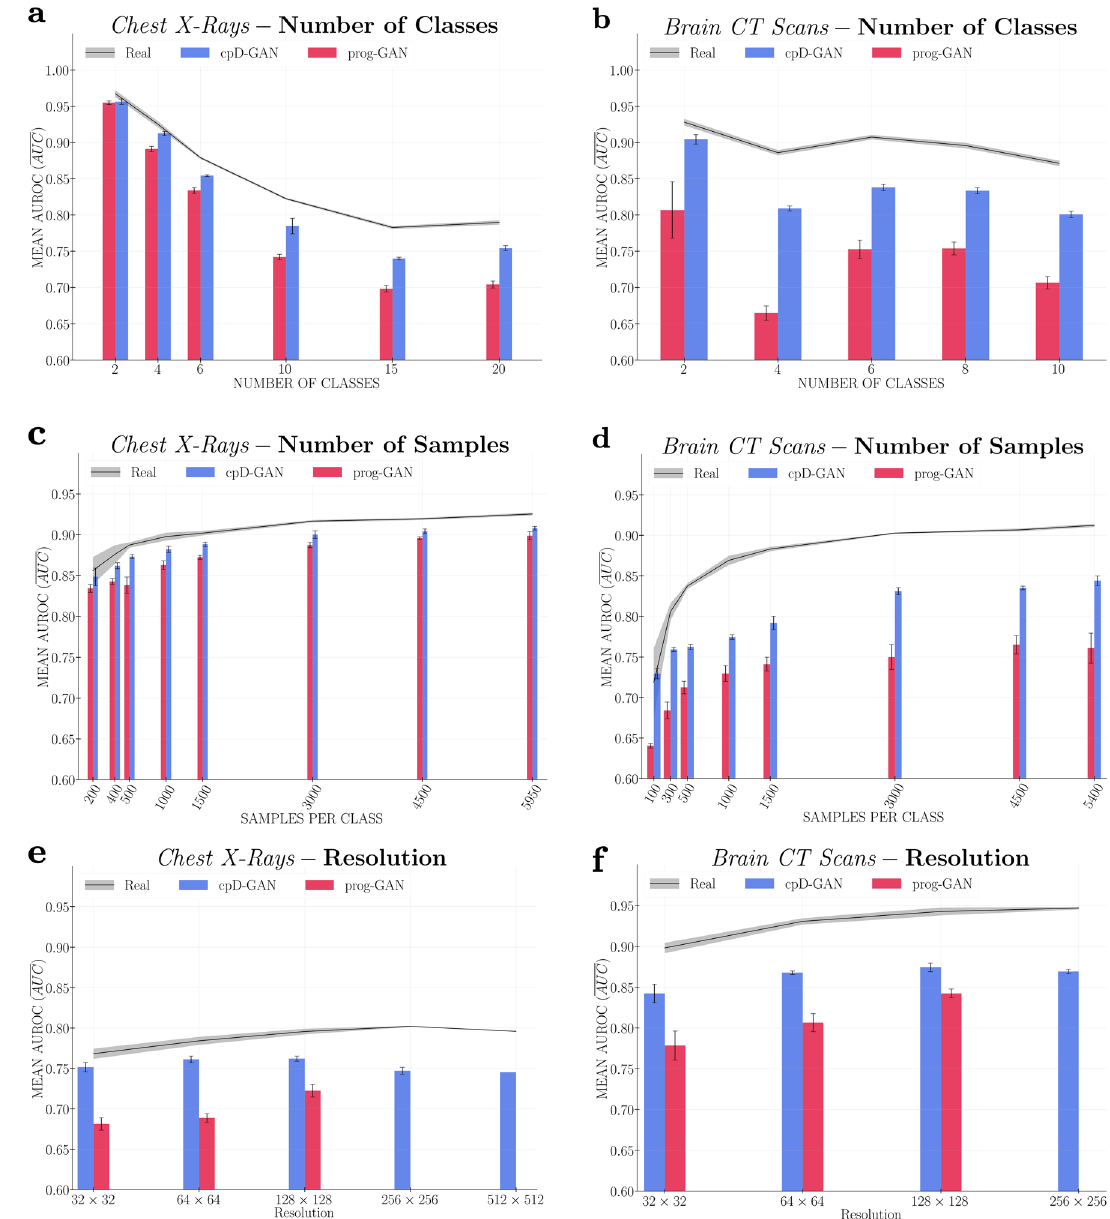
Fig. 2 Benchmark results. In each fi gure, we show the mean area under the receiver operator characteristic curve score ð AUC Þ on a held-out test fold of real data. The AUC scores obtained after training classi fi ers on real data ð AUC real Þ are indicated by the black line with the shaded area representing the standard deviation across repeated experiments. The bar plots represent the AUC scores achieved after training classi fi ers on synthetic data ð AUC syn Þ generated by the cpD-GAN (blue) and prog-GAN (red), while the error bars indicate the standard deviation. The sub- fi gures show the changes in predictive performance observed when varying the number of classes (or label combinations): a for chest radiographs, and b for brain computed tomography (CT) scans; the number of samples per class: c for chest radiographs, and d for brain CT scans; and the image resolution: e for chest radiographs, and f for brain CT scans. In ( e ) and ( f ) only the cpD-GAN is evaluated at resolution levels above 128 × 128 pixels. In ( e ) at 512 × 512 pixels we perform a single training run. Please see Table 1 for more details on the dataset composition for each benchmark